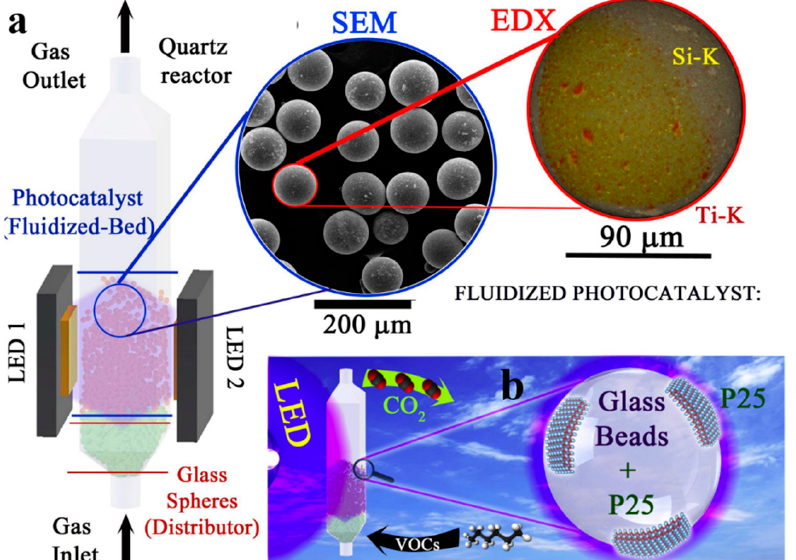
Figure 3. Scheme describing the different parts of the fluidized bed photoreactor ( a ) and the sche- matic of VOCs removal mechanism ( b ) [85]. Copyright 2019, Elsevier. of VOCs removal mechanism ( b ) [85]. Copyright 2019,